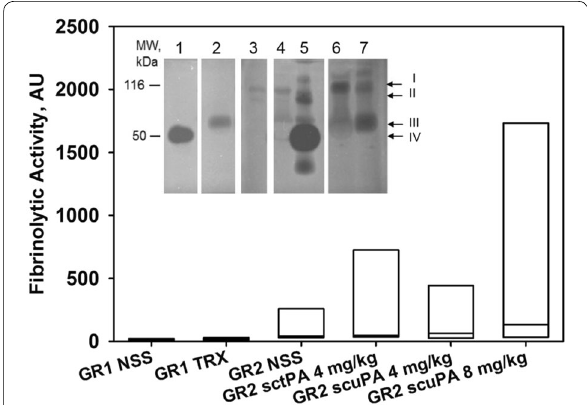
Fig. 7 Assessments of fibrinolytic activity in BAL samples. Generation of fibrinolytic activity by BAL fluids in the presence of human plasminogen. Box plots: relative fibrinolytic activity (FA), produced by BAL fluids (Gr1: 5 saline-controls, GR1 TRX: 11 scuPA and tPA treated animals; Gr2: 6 saline controls, 5 and 7 animals treated with 4 and 8 mg of nebulized scuPA respectively, and 5 animals treated with 4 mg nebulized tPA) in the presence of 100 nM human Glu-plasminogen. Data are presented as box plots (showing interquartile ranges). No statistically significant differences were noted in the median value of FA between the groups. Inset: enzymographic analyses of BAL fluids from animals with ISIALI. BALs were collected at 48 h after initiation of the treatment at the time of euthanasia. Arrows to the right of the panels indicate positions of: tPA/PAI-1 inhibitory complexes (110 kDa) (I), uPA/PAI-1 inhibitory complexes (100 kDa) (II), tPA (63 kDa) (III), uPA (50 kDa) (IV). To illustrate the range of activity in the treatment groups, samples the range of ones with low levels of PA and relatively higher PA levels from sheep included in Group 2. Lanes: recombinant human uPA (0.5 ng) and tPA (0.1 ng) standards are shown in lanes 1 and 2, respectively. 3: saline treated animal, 4 and 5—8 mg scuPA-treated animals, 6 and 7—4 mg tPA-treated animals. The data are representative of the findings in all similarly treated Group 2